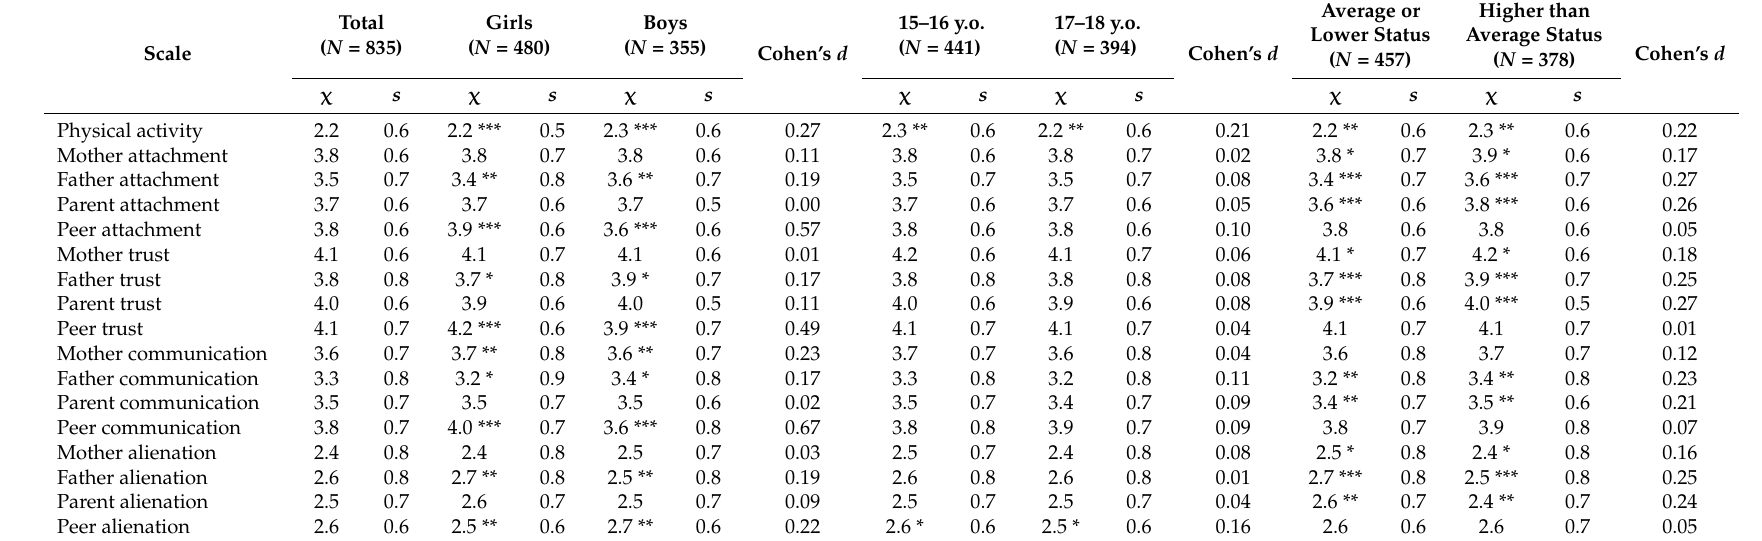
Mean scores ( χ ), standard deviation ( s ) , and Cohen’s d effect size of physical activity (PA), mother/father/peer attachment, parent/peer trust/communication/alienation stratified by gender, age, and SES, N = 835.